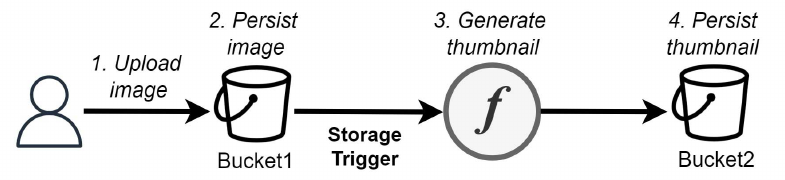
Figure 5. Use case 1— thumbnail generation .